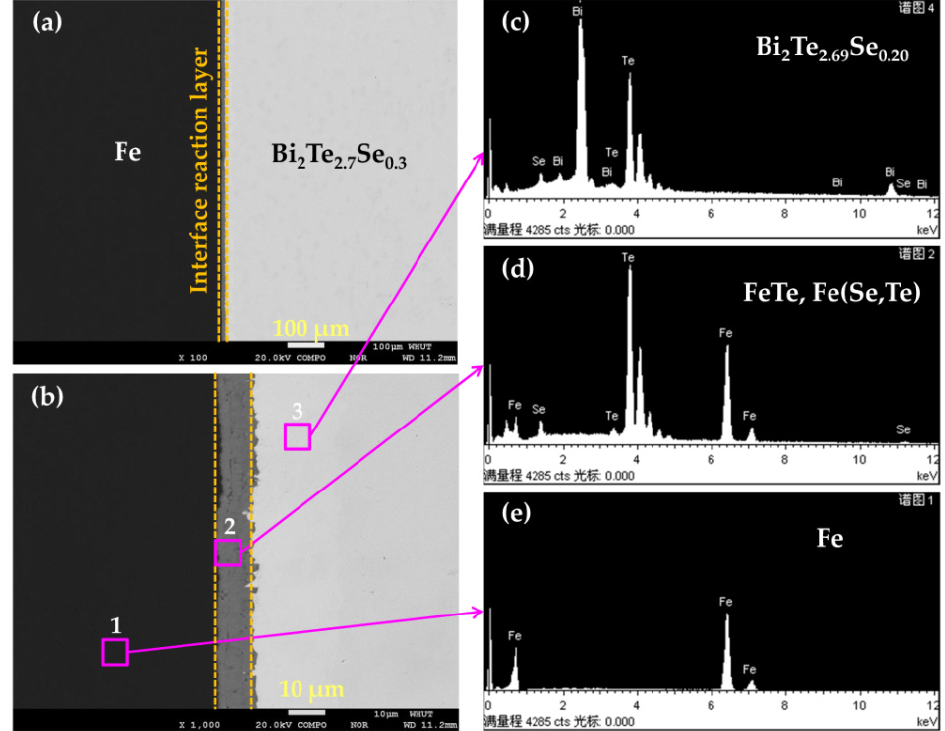
Figure 5. ( a , b ) BEI; ( c , d , e ) EDS results of Fe/BTS artificially tilted multilayer block.